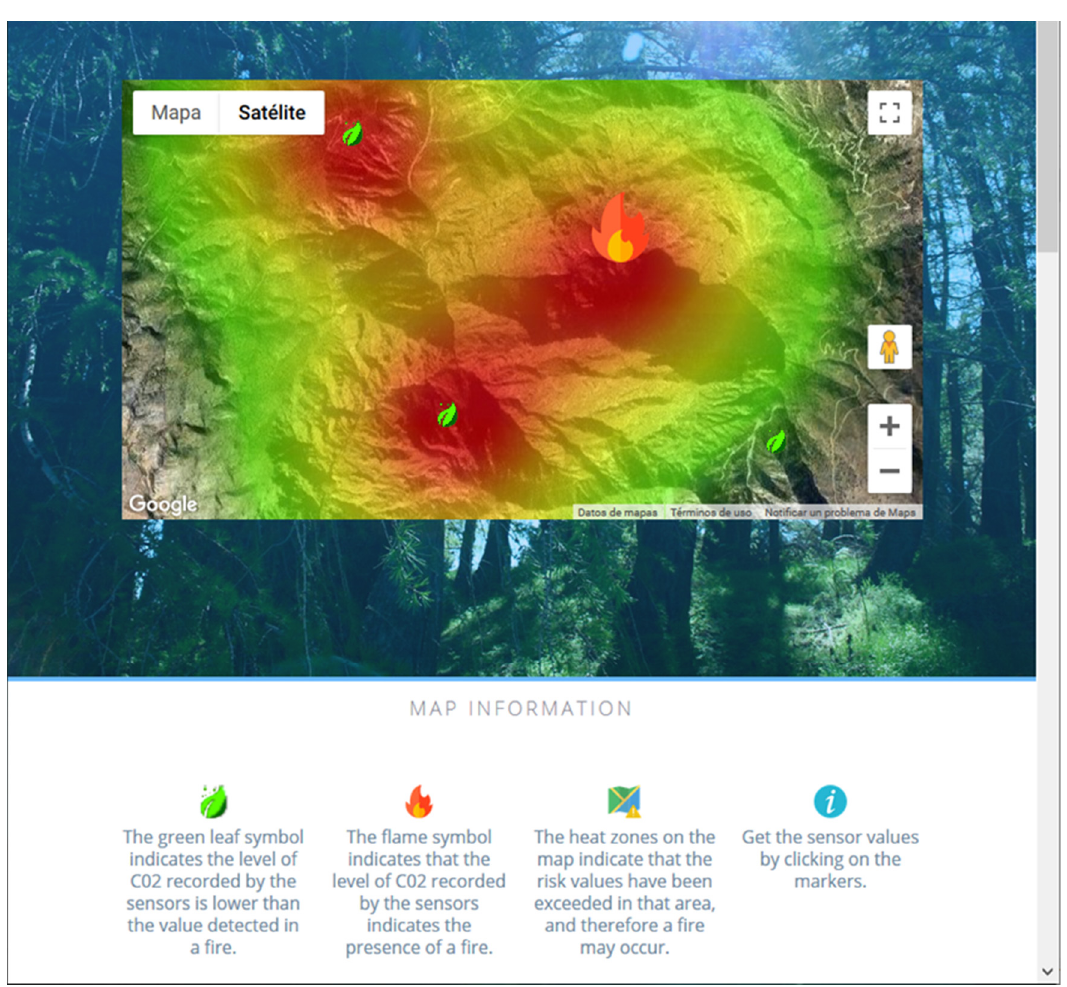
Figure 13. Website showing 4 nodes.